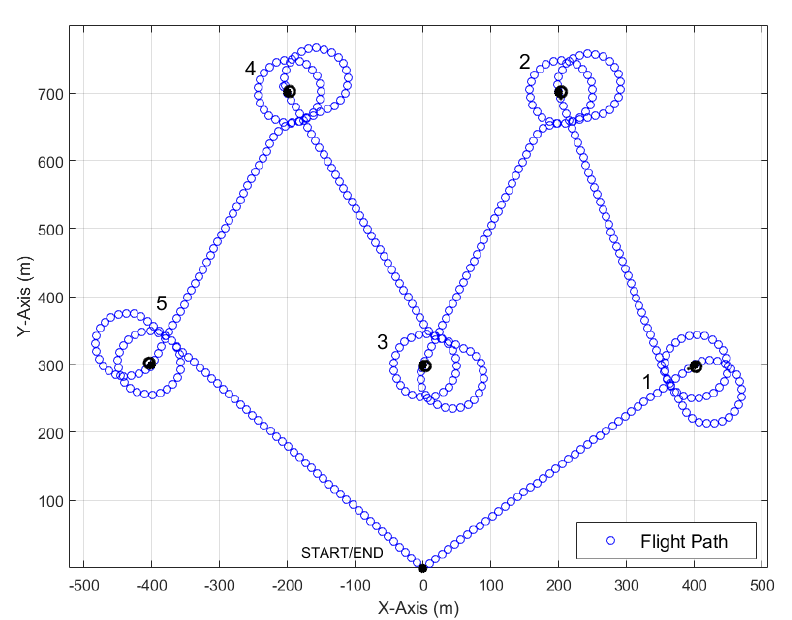
Figure 6. Fly through